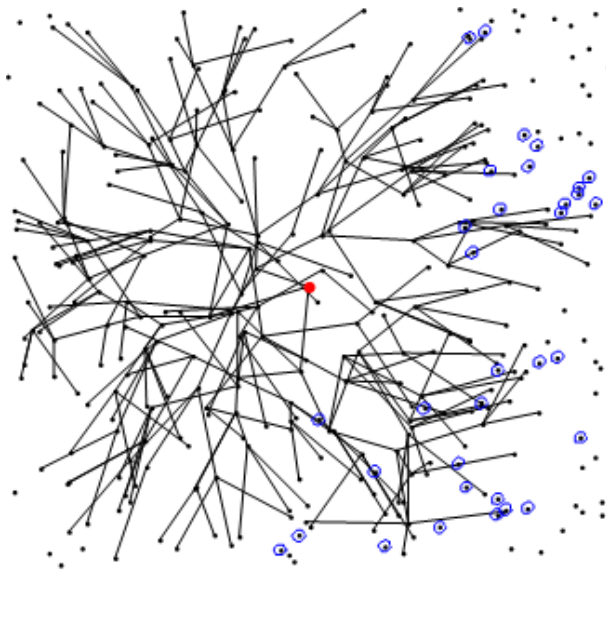
Figure 3. ZigBee associated